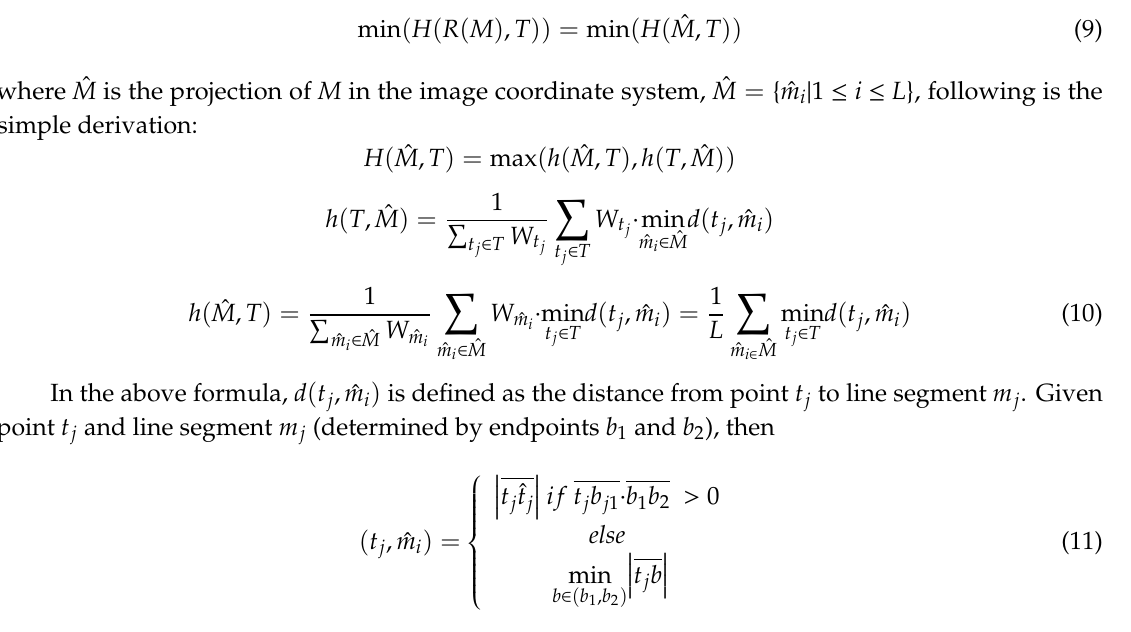
Figure 7. Distance from point 𝑡